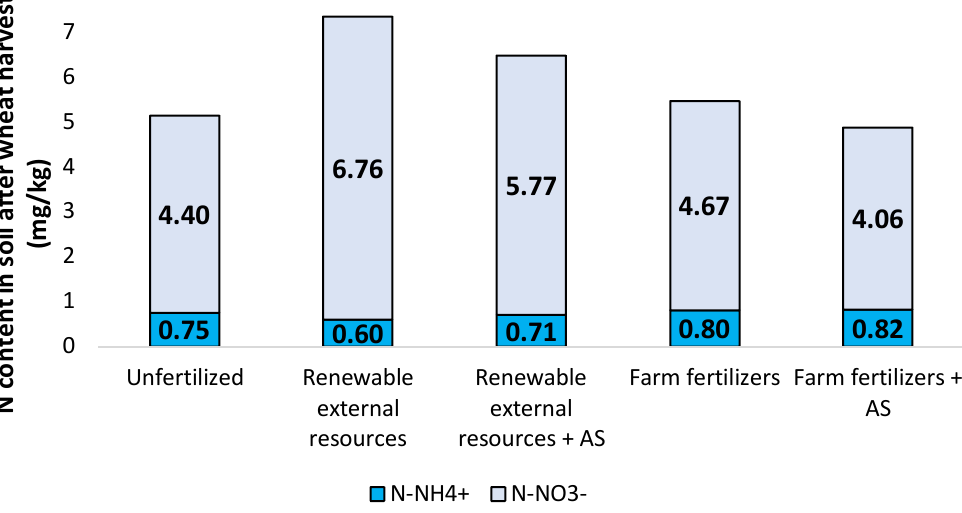
Figure 2. Content of mineral nitrogen in the soil after the harvest of winter wheat (observed treatments, 2015).